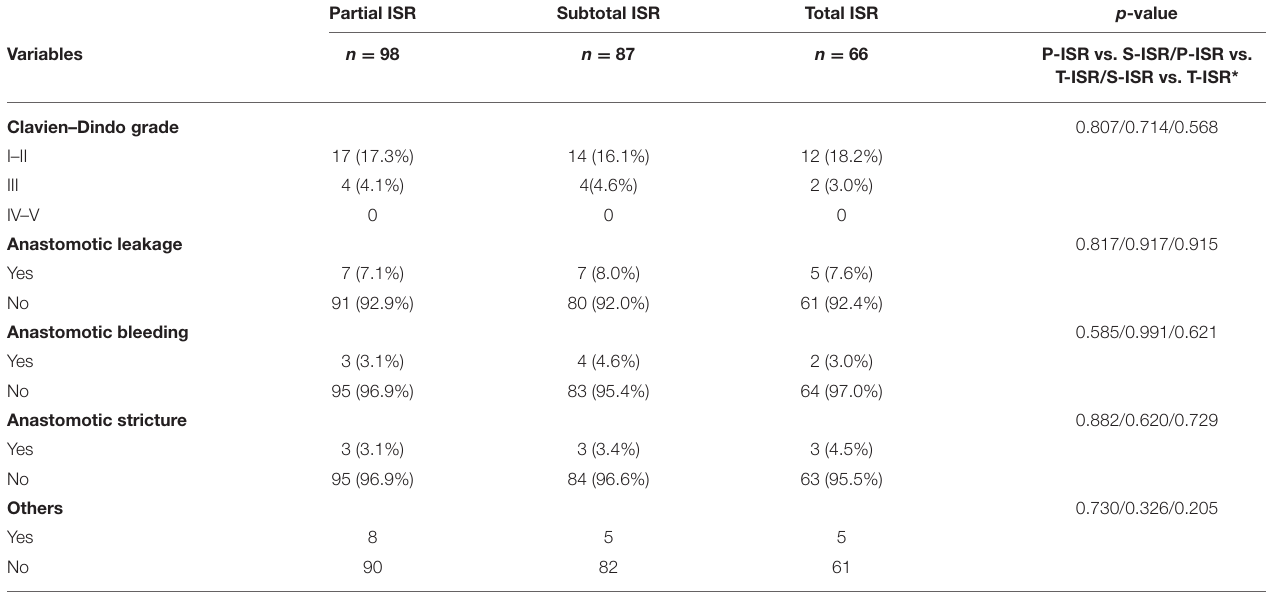
TABLE 3 | Postoperative complications in patients. Partial ISR Subtotal ISR Total ISR p -value Variables n = 66 P-ISR vs. S-ISR/P-ISR vs.